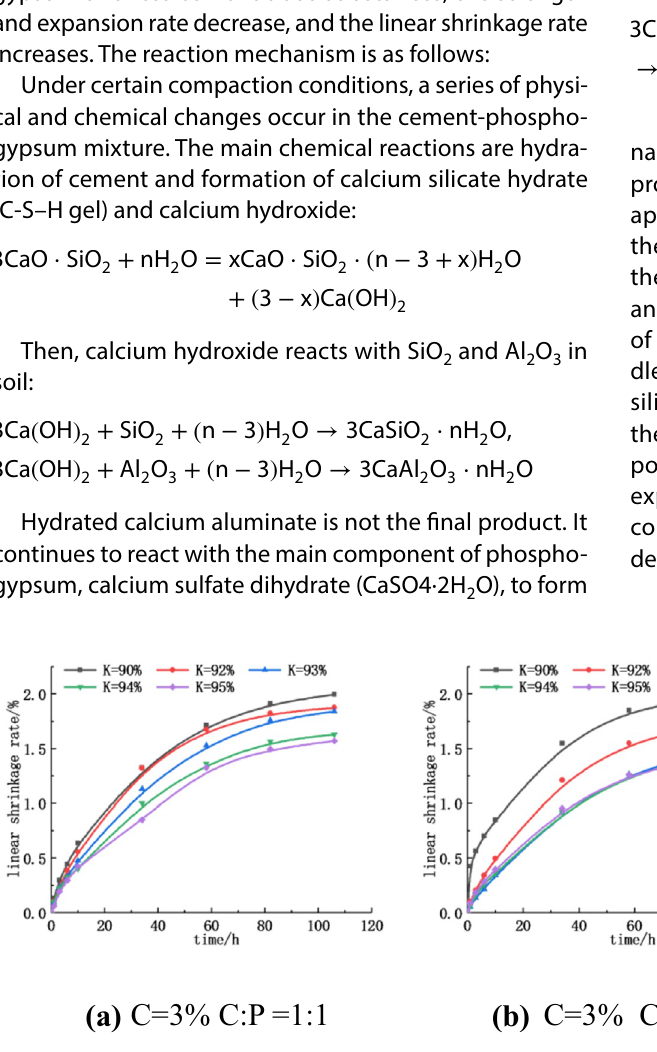
Fig. 7 Relationship between linear shrinkage of mixture and time (3% cement)